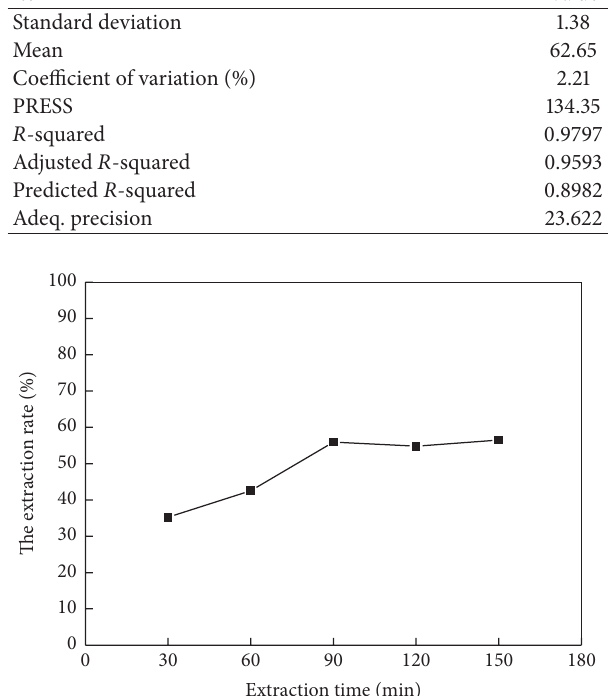
Figure 5: Effects of extraction time on the extraction rate of saponin (liquid-solid ratio 10mL/g, alkali solution pH value 10, extraction temperature 60 ∘ C, and acid isolation pH value 3).